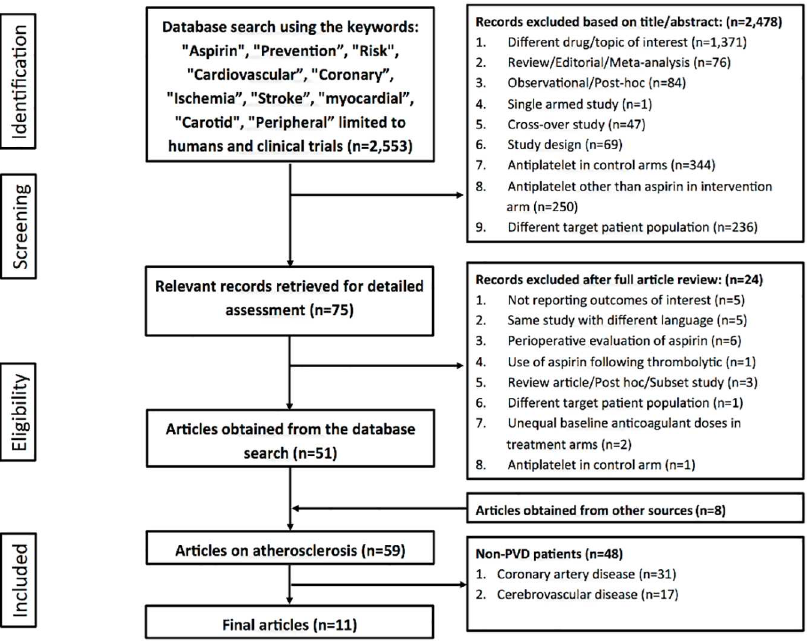
Fig 1. Summary of how the systematicsearch was conducted and eligible studies were identified (PRISMA flow diagram). PVD = peripheral vascular disease.